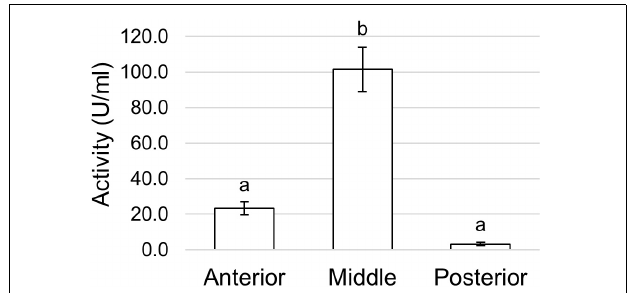
FIGURE 13 | Lysozyme activity assayed in the different midgut regions measuring the rate of lysis of Micrococcus lysodeikticus . The values are reported as mean ± SEM of at least 3 experiments. Different letters denote significant differences (ANOVA test followed by Tukey’s test. ANOVA p -value < 0.001, Tukey’s test p -values: Middle vs. Anterior p < 0.001, Posterior vs. Anterior p = 0.394, Posterior vs. Middle p <